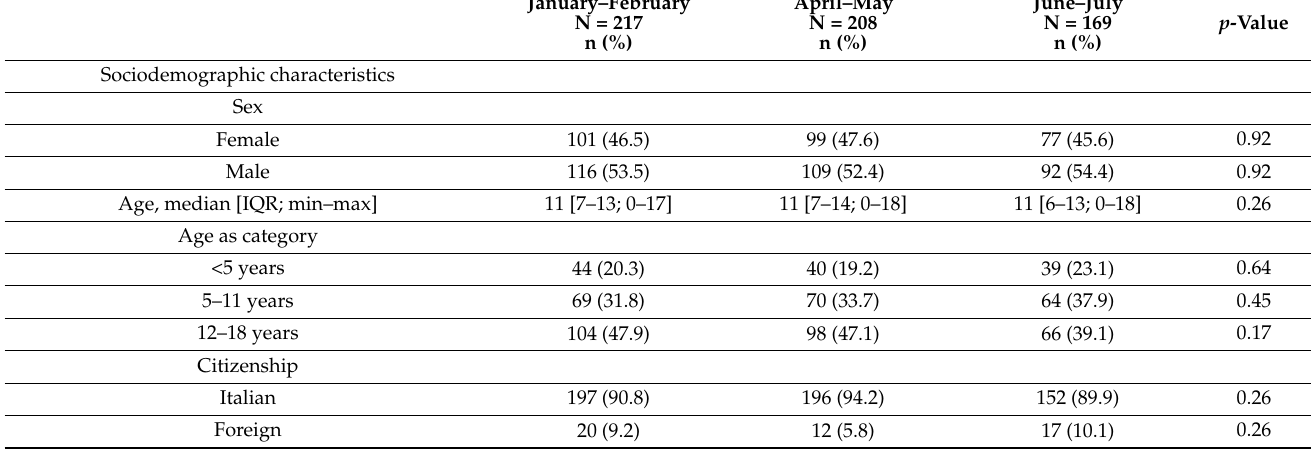
Table 1. Children characteristics in the three time periods.